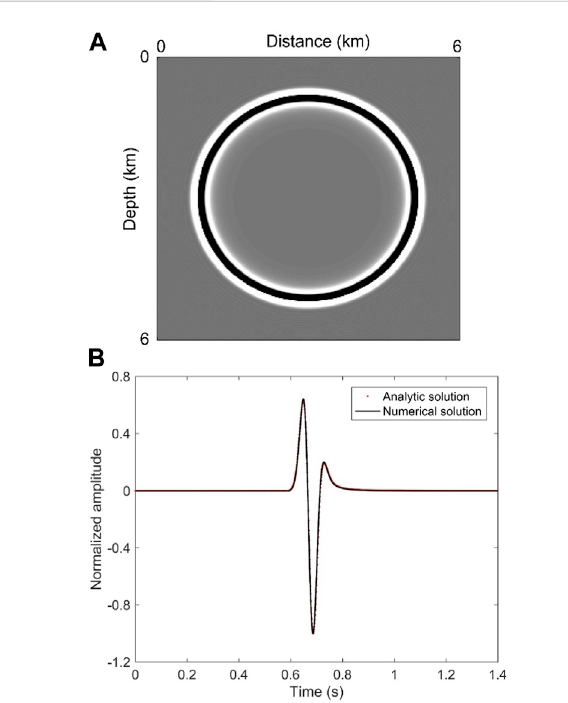
FIGURE 3 (A) Snapshots of the acoustic wave fi elds at t = 0.8 s, and (B) normalized waveform records in [0 s, 1.4 s] computed by the MSDG method in homogeneous acoustic medium.